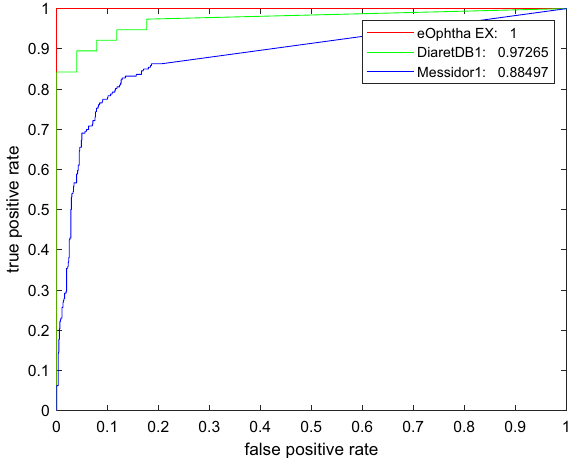
Figure 6. AUC-ROC curve at the image-level of our method on the e-ophtha-EX, DiaretDB1, and Messidor1 datasets.